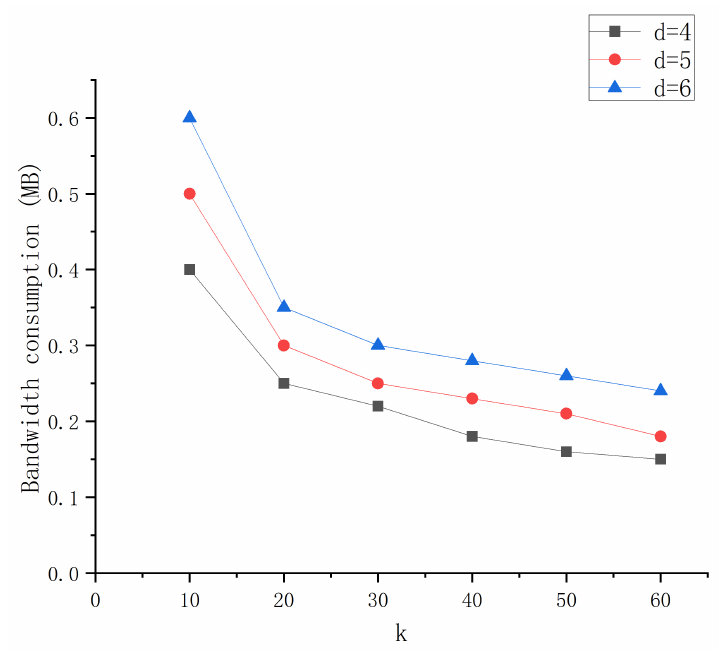
Figure 3. Bandwidth consumption during encoding.